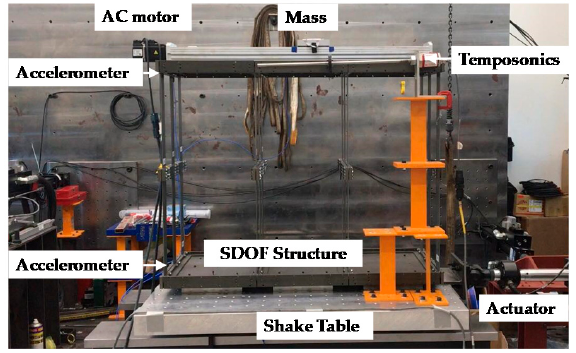
Figure 11. Experimental setup for the validating tests.